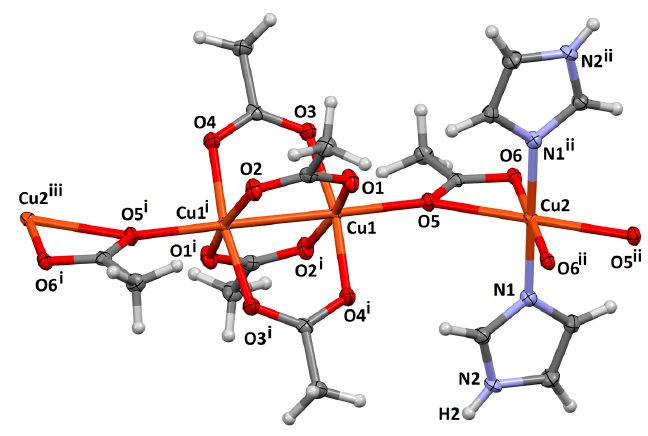
Figure 2. One subunit of the infinite chain for 1 , represented with 50% displacement